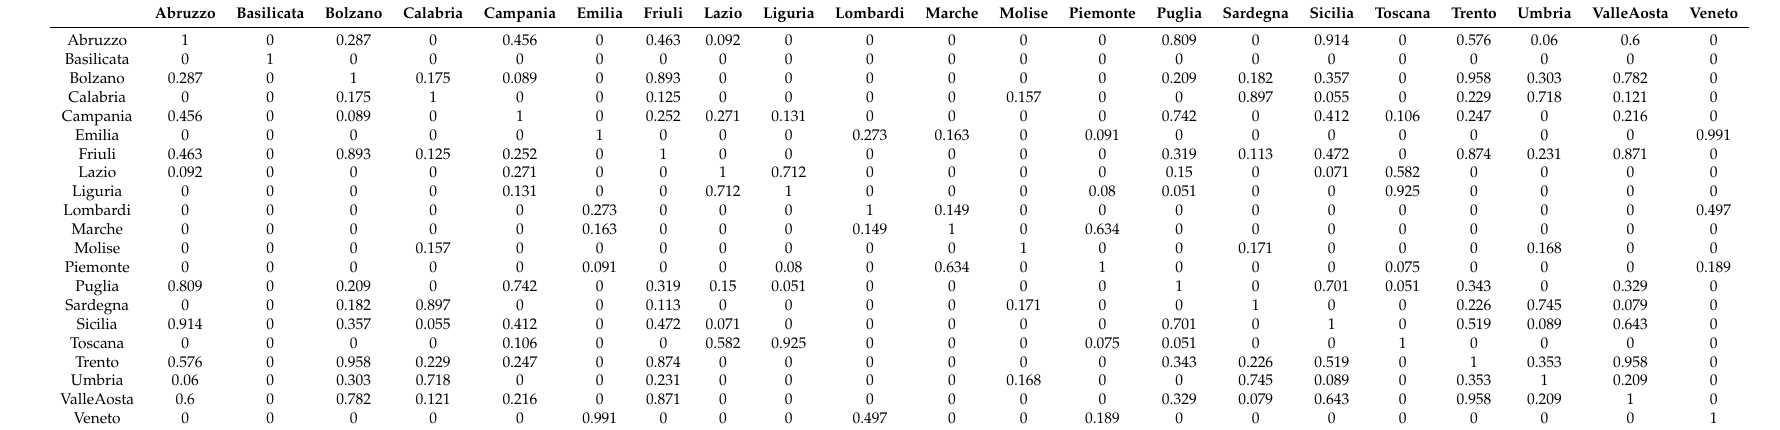
Table A1. Similarity values of Hospitalized with Symptoms network in the study period.